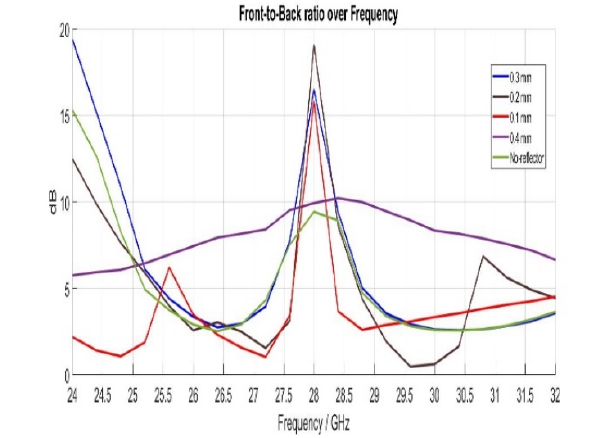
Fig 8. Effect of substrate thickness ( ℎ (cid:2871) ) for Reflector Patch on Front-to-back Ratio.